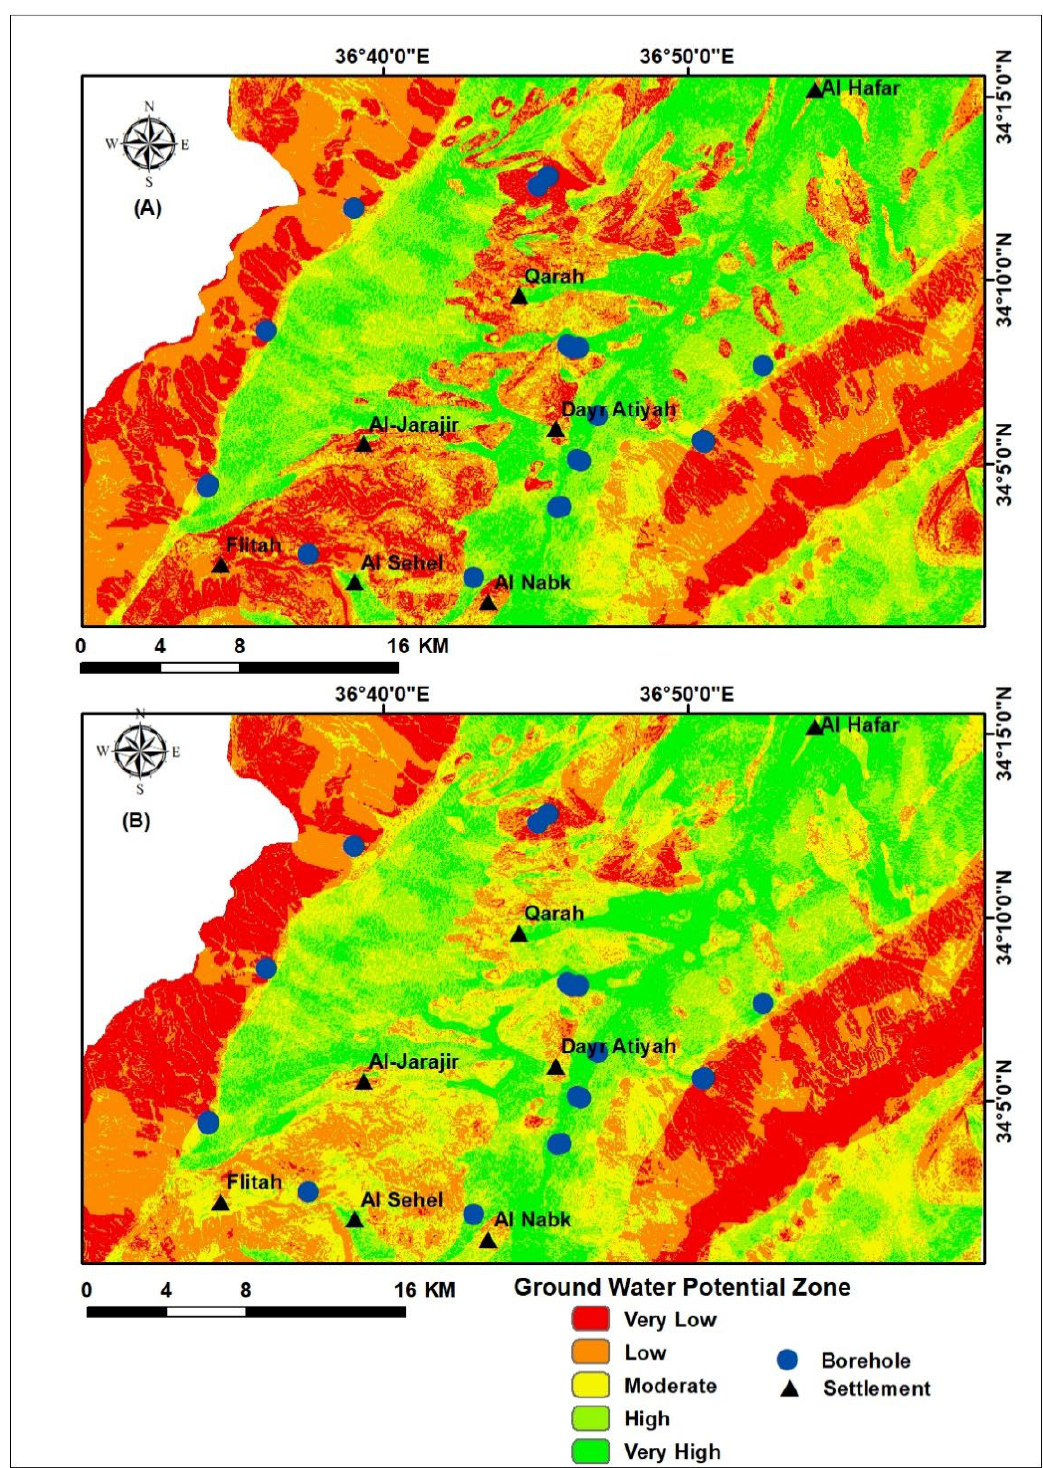
Figure A2. Groundwater Potential Zone of the ( A ) AHP2 and ( B ) MIF2 maps. Table A3. Weight and scores of specific characteristics in (MIF3 and AHP3) are assigned to factors that influence GWPZ.